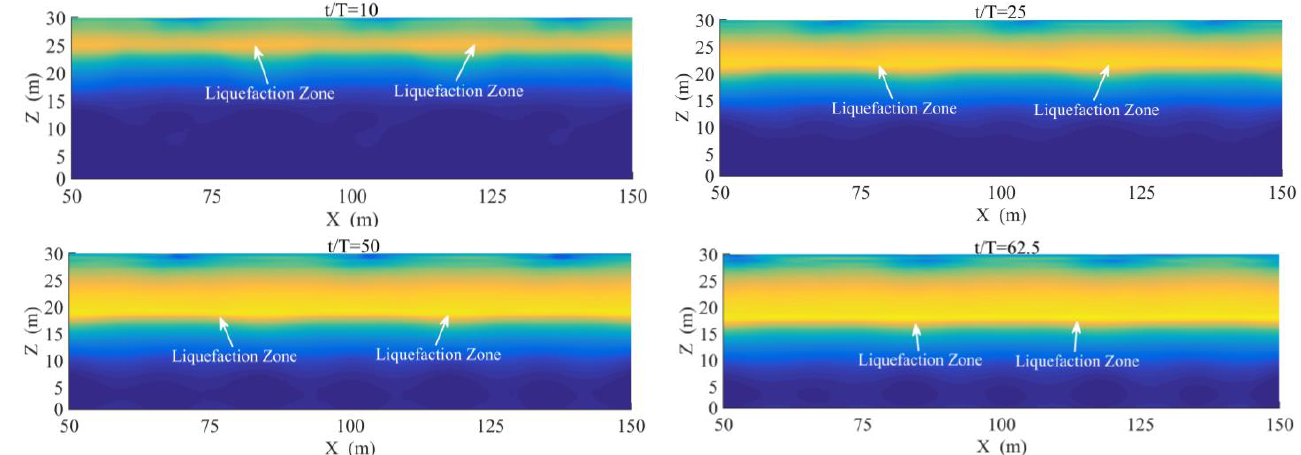
Figure 9. Cnoidal wave-induced residual liquefaction zone in loose seabed floor at typical time t / T = 10, 25, 50, and 62.5.